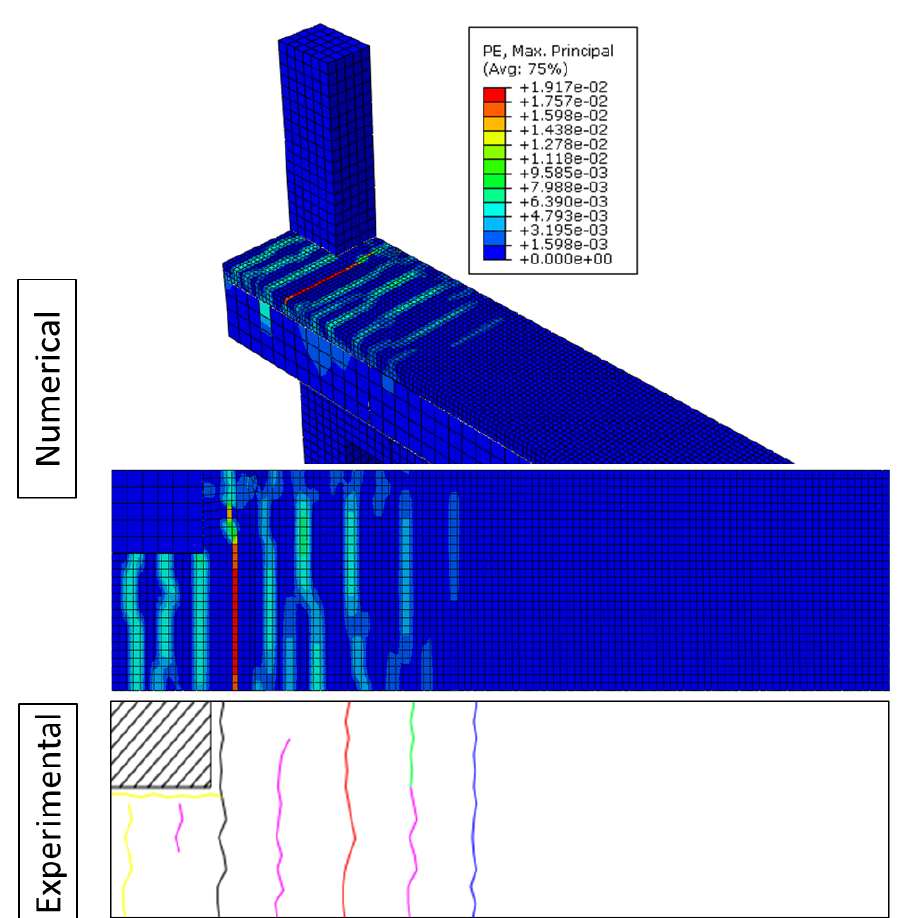
Figure 9. Comparison of the cracking pattern of the models. (Adapted from Miotto